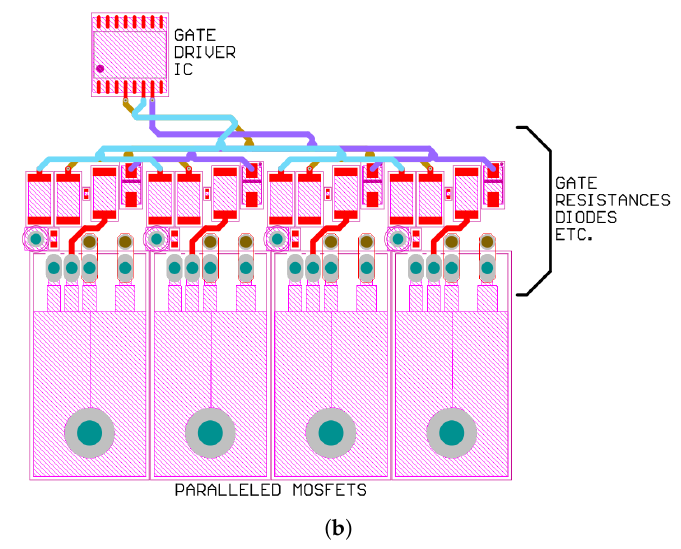
Figure 4. Layout of the gate driver circuit, ( a ) Gate turn-on path “yellow trace”, ( b ) gate turn-off path “blue